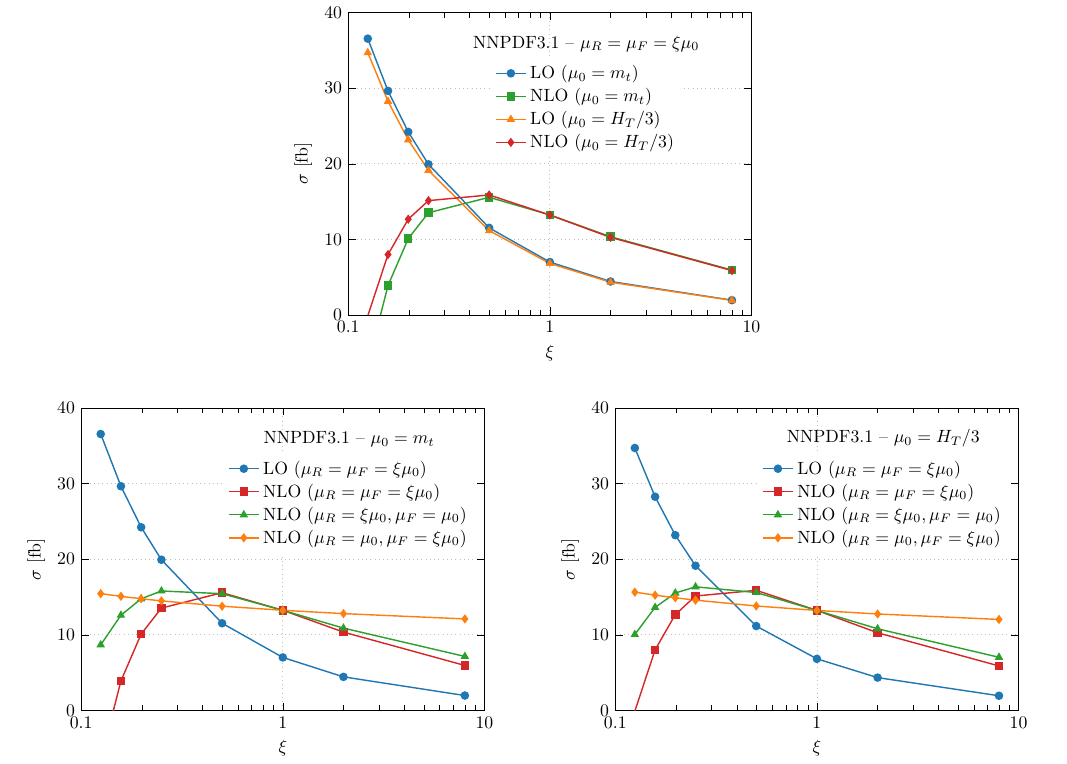
Figure 4 . Scale dependence of the LO and NLO integrated fiducial cross sections for the pp → √ e + ν e µ − ¯ ν µ b ¯ b b ¯ b + X production process at the LHC with s = 13 TeV. Renormalisation and factorisation scales are set to the common value µ R = µ F = µ 0 with µ 0 = m t and µ 0 = H T / 3 . The LO and NLO NNPDF3.1 PDF sets are employed. For each case of µ 0 also shown is the variation of µ R with fixed µ F and the variation of µ F with fixed µ R